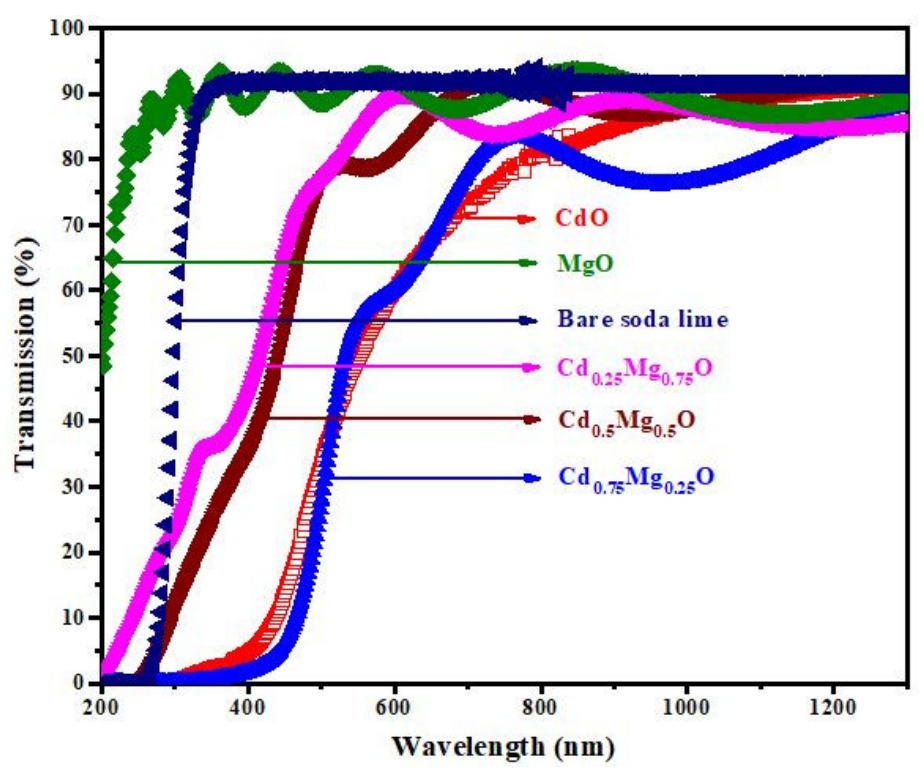
Figure 6. Transmittance spectra of ( a ) CdO; ( b ) Cd 0.75 Mg 0.25 O; ( c ) Cd 0.5 Mg 0.5 O; ( d ) Cd 0.25 Mg 0.75 O; and ( e ) MgO annealed thin films.